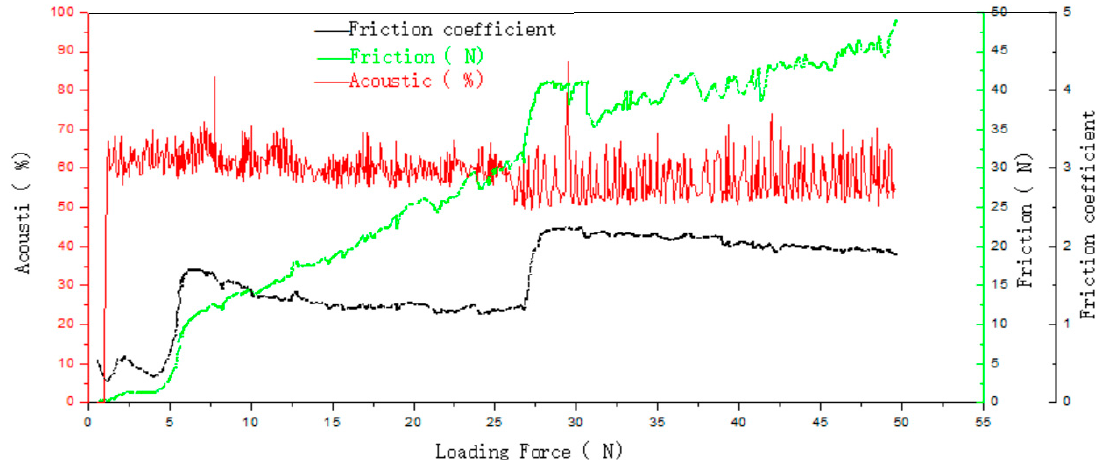
Figure 3. Scratch test of composite coating.